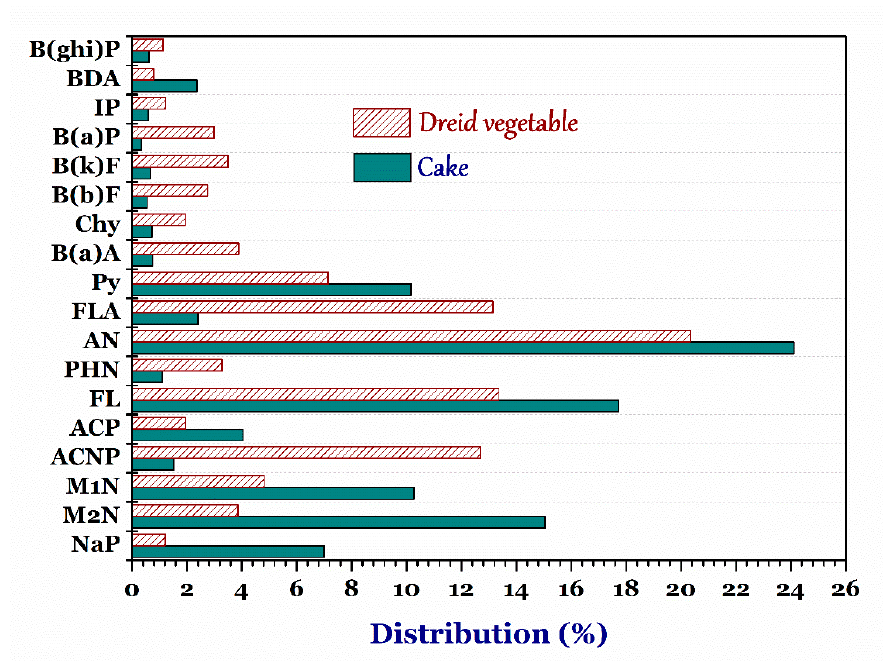
Figure 4. Distribution percentage of diffident kinds of polycyclic aromatic hydrocarbons. Note: naphthalene, NaP; 2-methylnaphthalene, M2N; 1-methylnaphthalene, M1N; acenaphthylene, ACNP; acenaphthene, ACP; fluorene, FL; phenalthrene, PHN; anthracene, AN; floranthene, FLA; pyrene, Py; benzo(a)athracene, B(a)A; chrysene, Chy; benzo(b)fluoranthene, B(b)F, benzo(k)fluoranthene, B(k)F; benzo(a)pyrene, B(a)P; indeno(1,2,3-cd)pyrene, IP; dibenz(a,h)anthracene, BDA; and benzo(g,h,i)perylence, B(ghi)P.